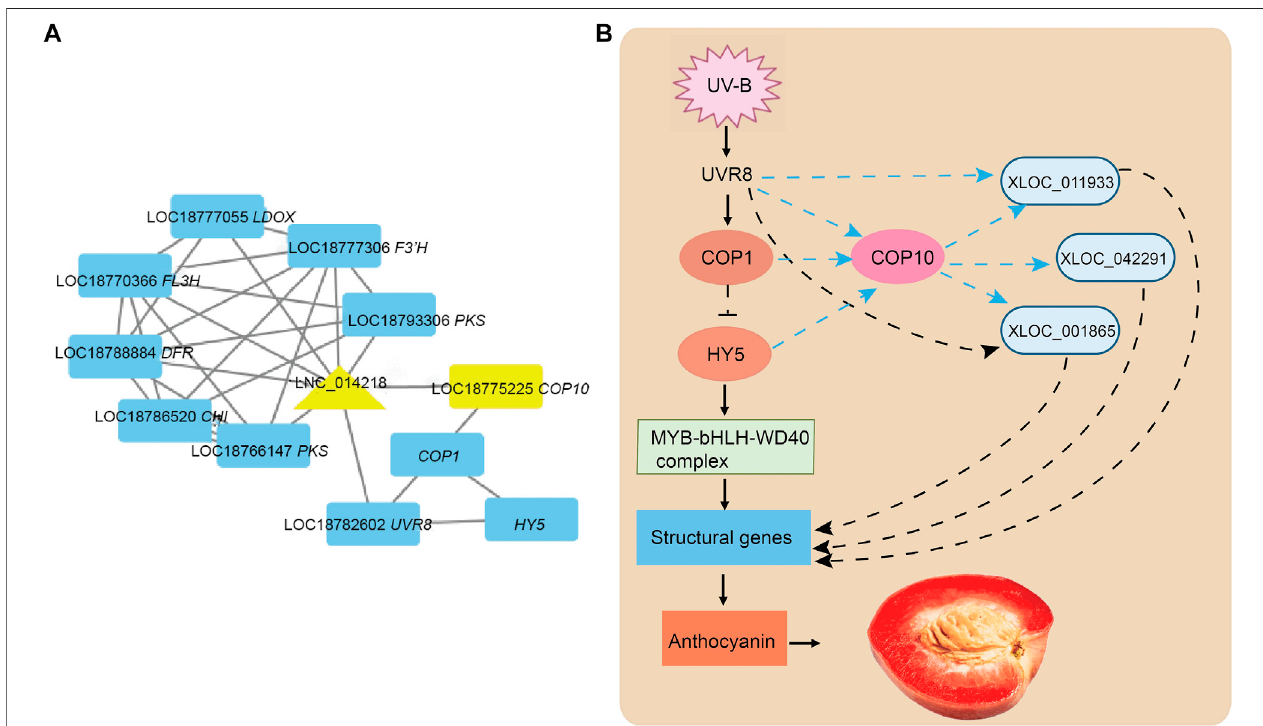
FIGURE 4 | Analysis of XLOC_042291, XLOC_011933, and XLOC_001865 involved lncRNA – mRNA networks associated with UV-B induced in anthocyanin biosynthesis. (A) Sub-interaction networks ofXLOC_042291,XLOC_011933,and XLOC_001865from lncRNA – mRNAnetworks.ThetrianglerepresentslncRNAs and the rectangle represents mRNAs. (B) Model diagram of UV-light-mediated fruit development of red meat peach. COP1 , constitutive photomorphogenic 1; COP10 , constitutive photomorphogenic 10; HY5 , ELONGATED HYPOCOTYL 5; UVR8 , UV RESISTANCE LOCUS 8; Ub, ubiquitin.